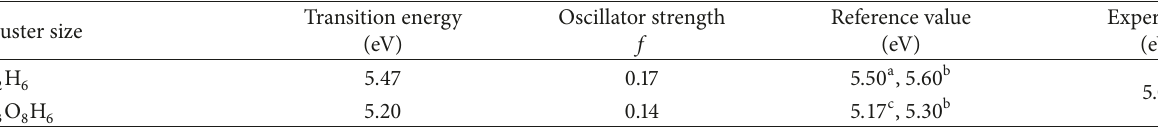
Table 3: Summary of computed s 0 → s 1 transition energy for the ODC(II) defects cluster configurations, neglecting other paramagnetic defects.